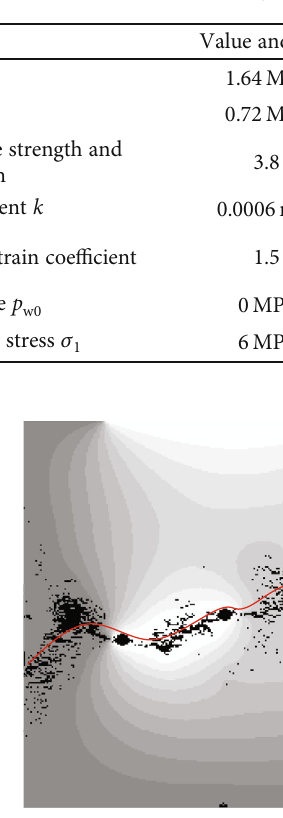
Table 1: Parameters used in this numerical simulation.